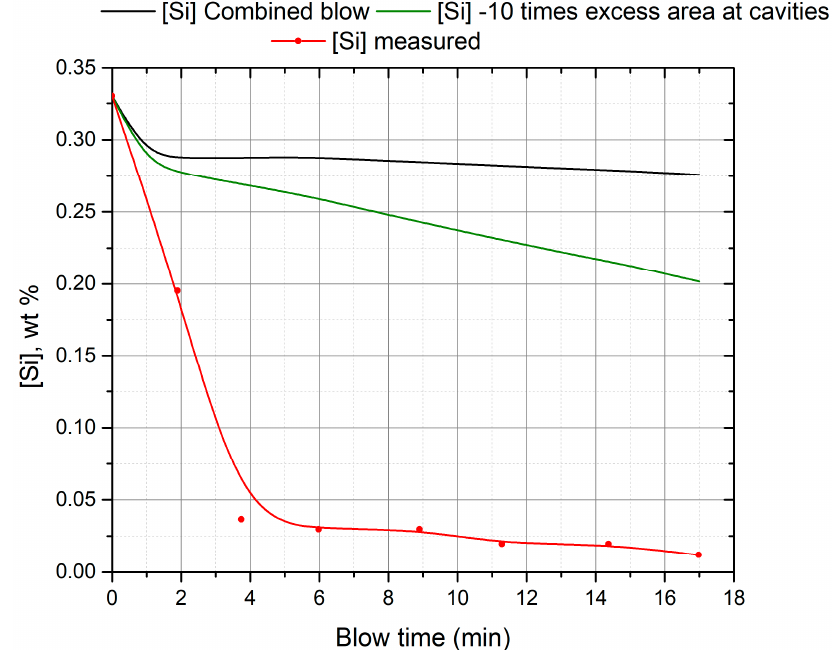
Figure 12. Effect of surface roughness on oxidation rate of silicon.